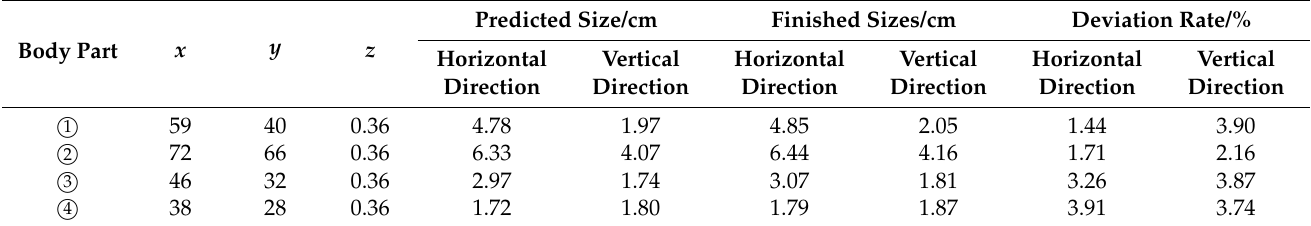
Table 4. The predicted and finished sizes of the sensors in different body parts.